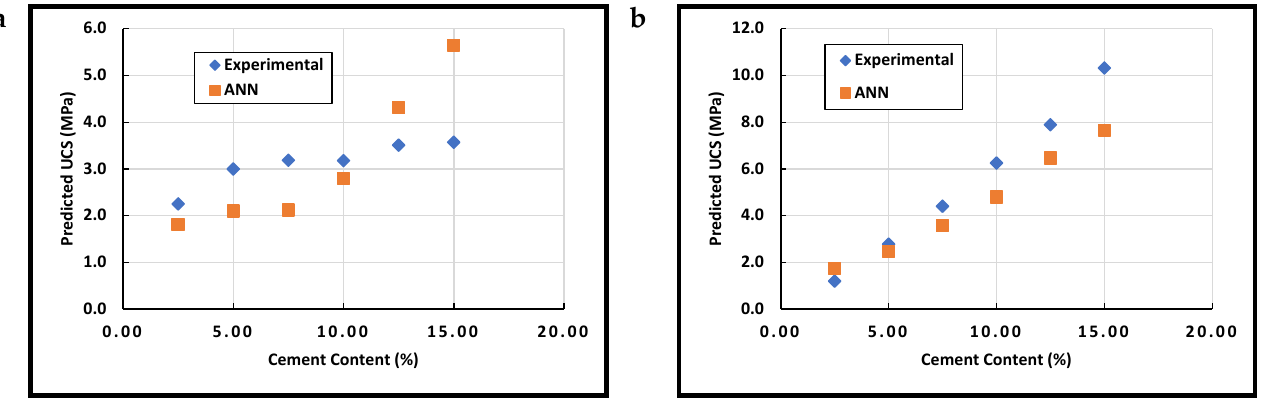
Figure 5. Model Validation for ( a ) Soil-1 and ( b ) Soil-2 (analyzed using the CEM-ANN network).